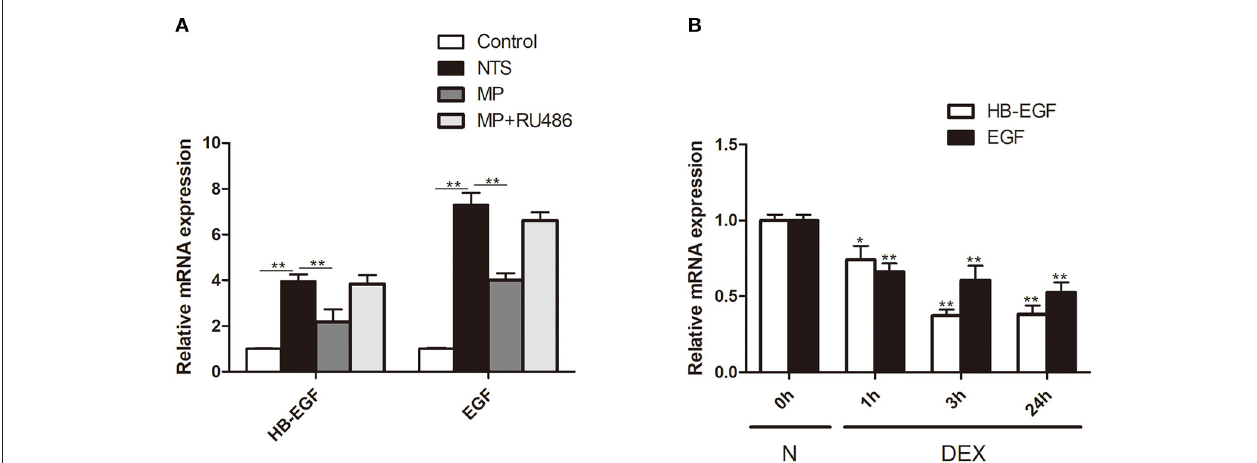
FIGURE 8 | Glucocorticoid treatment inhibited expression of EGFR ligands in vivo and in vitro . (A) Quantification by qRT-PCR of HB-EGF and EGF mRNA in isolated glomeruli of rats treated with saline (control), NTS, NTS + MP, NTS + MP + RU486, respectively on day 14 ( n = 5 per group). ** P < 0.01; (B) qRT-PCR analysis showing